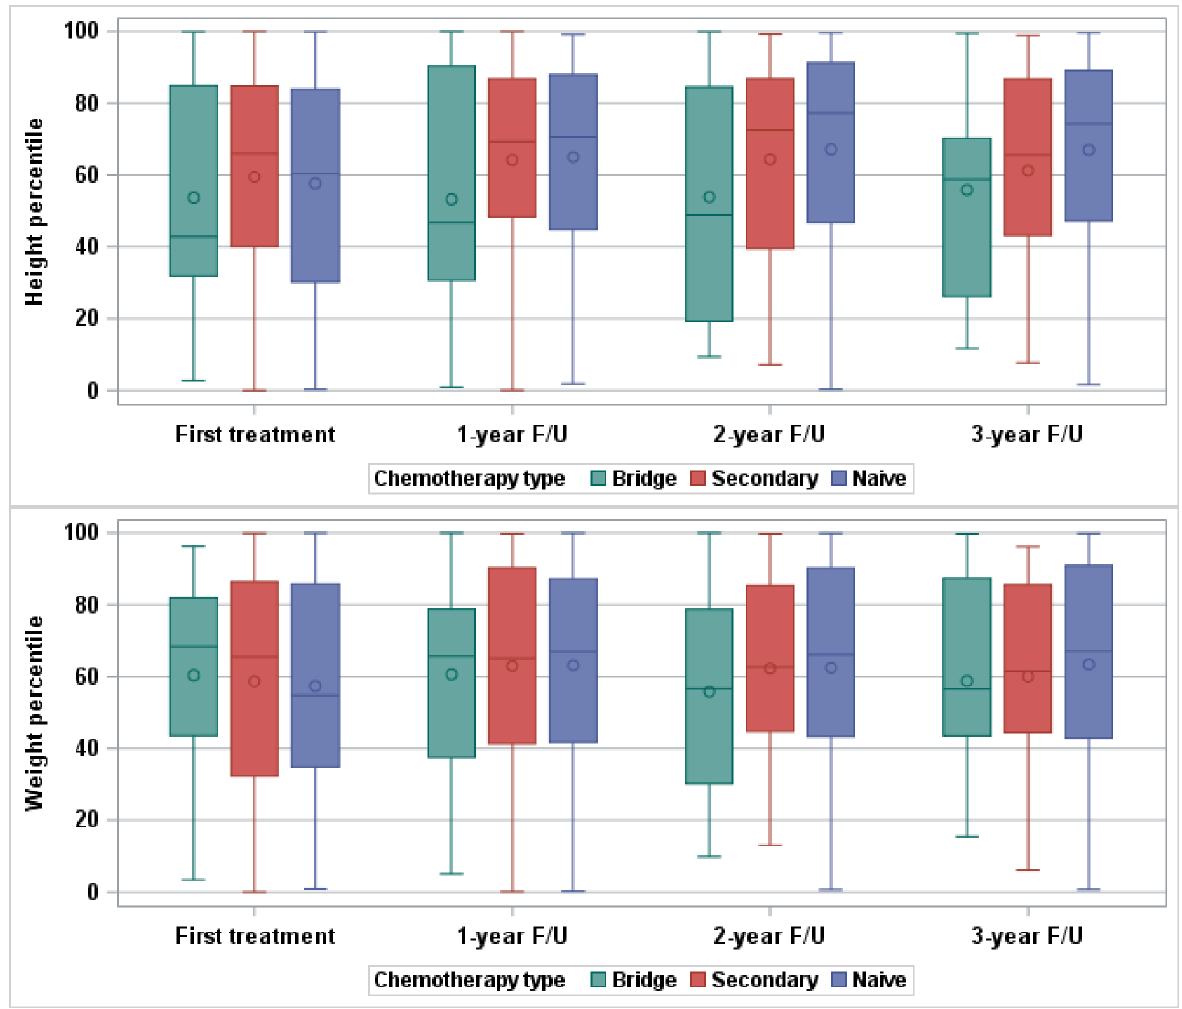
Fig 2. Height and weight percentiles at first treatment, 1, 2 and 3 year follow-up by chemotherapy group. Mean height percentiles are not significantly different by group at first treatment (ANOVA p = 0.72, n = 291), 1 year (p = 0.14, n = 276), 2 year (p = 0.06, n = 203) and 3 year (p = 0.49, n = 134) follow-up. Mean weight percentiles are also not significantly different by group at first treatment (p = 0.86, n = 334), 1 year (p = 0.93, n = 290), 2 year (p = 0.65, n = 209) and 3 year (p = 0.73, n = 137)